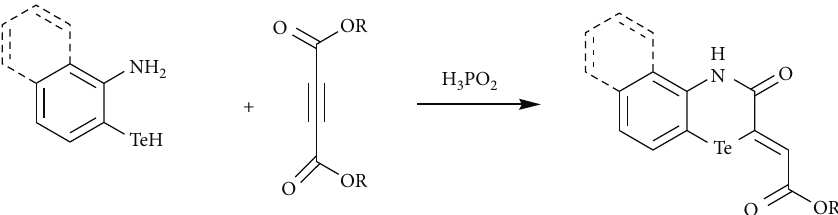
3 ; naphthalene derived: